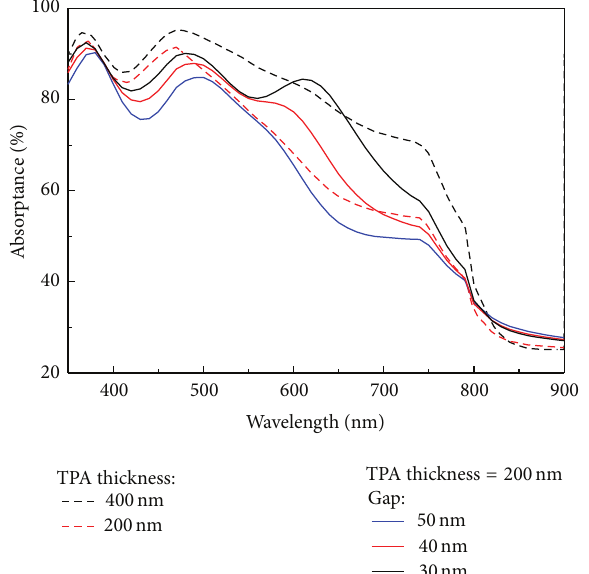
Figure 5: The red (black) dashed line indicated the absorptance of the TPA/ITO/glass when the TPA thickness is equal to 300 nm (400 nm). The blue, red, and black lines show the absorptance of the TPA/ITO/glass with the Cu nanoplasmonic structure when the long axis of the Cu nanoparticles is